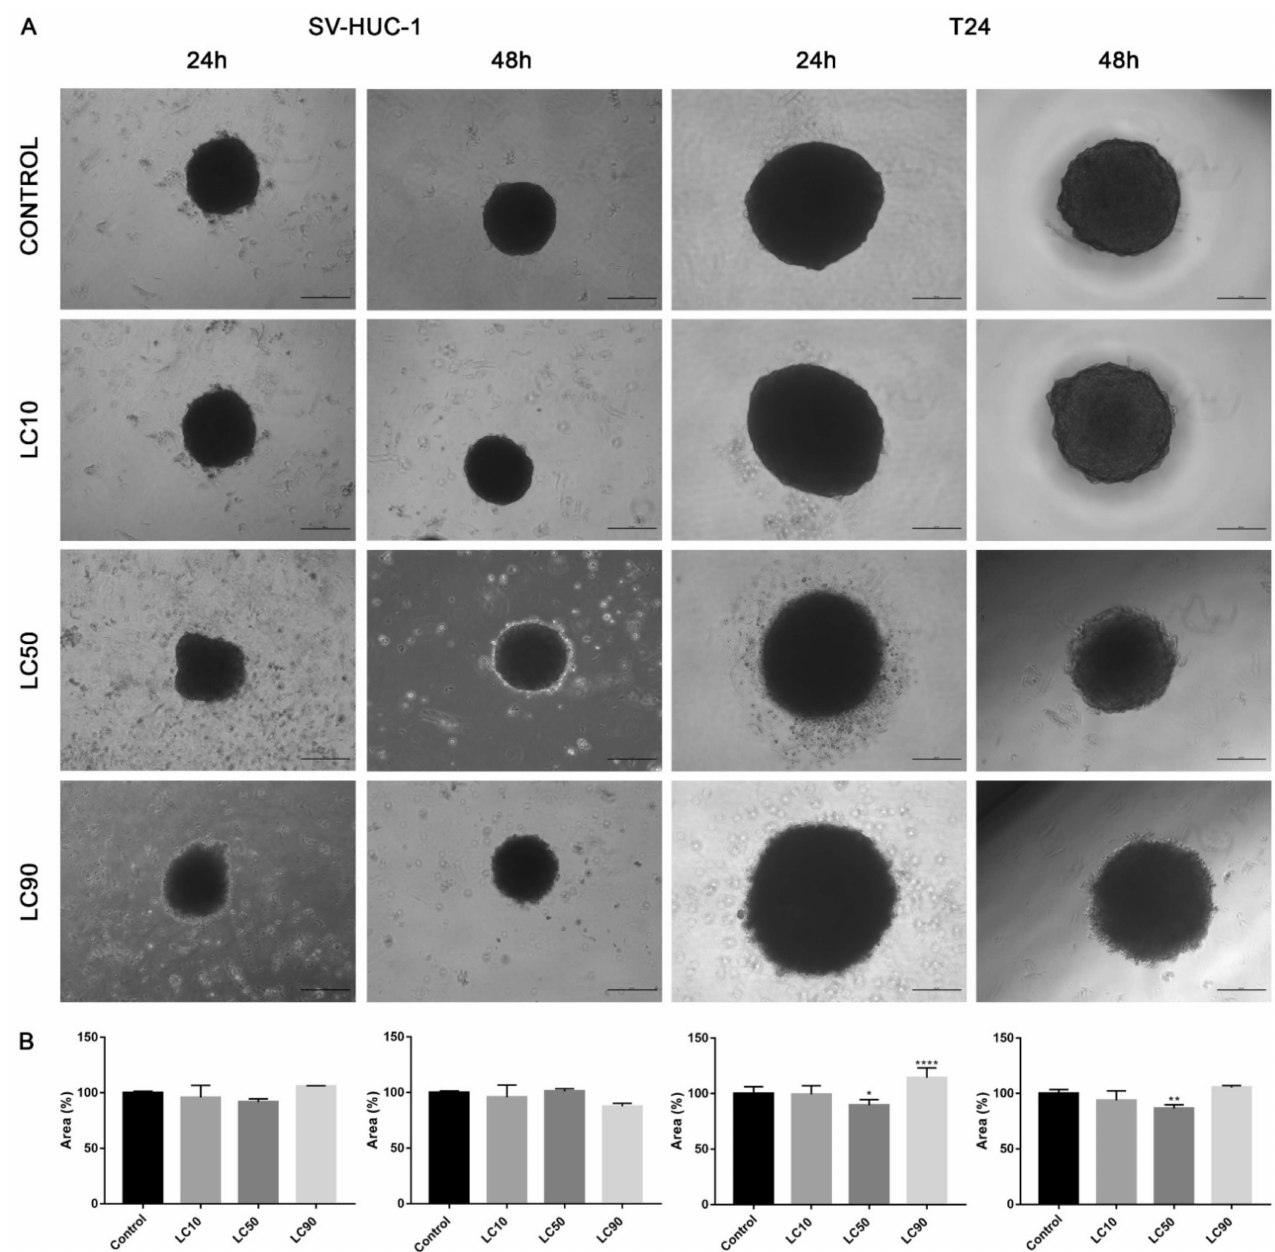
Figure 13. Morphology of bladder cells in 3D cell culture following levofloxacin treatment. ( A )—SV-HUC-1 and T24 cell lines treated with calculated lethal concentration obtained for levofloxacin, using an inverted light microscope (bar = 200 µ m). ( B )—Morphometric analysis of spheroids area. SV-HUC-1—non-malignant human urothelium; T24—human bladder cancer; statistically significant results compared to control were presented: LC—lethal concentration; *— p ≤ 0.05; **— p ≤ 0.01; ****— p ≤